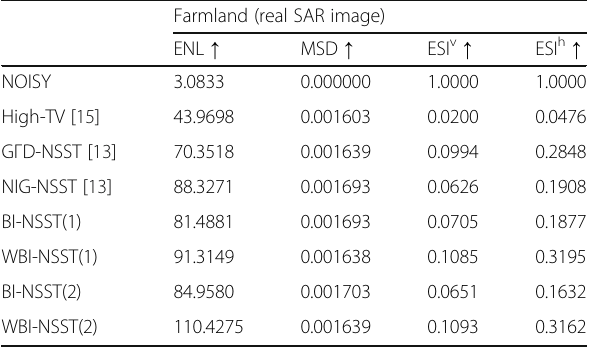
Table 5 Four no reference parameters to compare the performance of our proposed methods and references [13] and [15] for despeckling a real SAR image called Farmland Farmland (real SAR